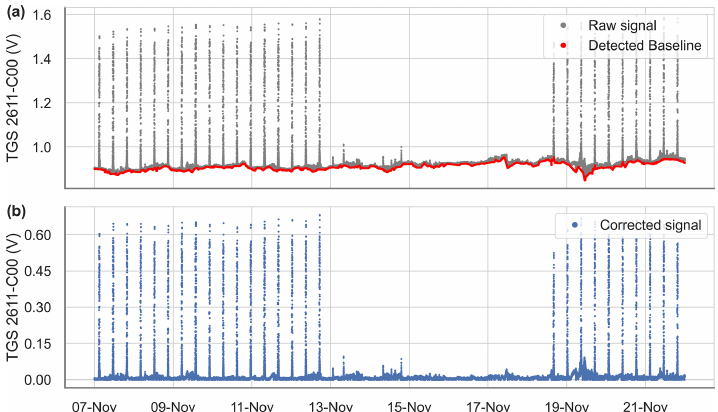
Figure A3. Example of the baseline extraction and correction for the Figaro ® TGS 2611-C00 over 15d. (a) Raw signal (gray) and detected baseline with the spike detection algorithm (red). (b) Voltage signal with the corrected